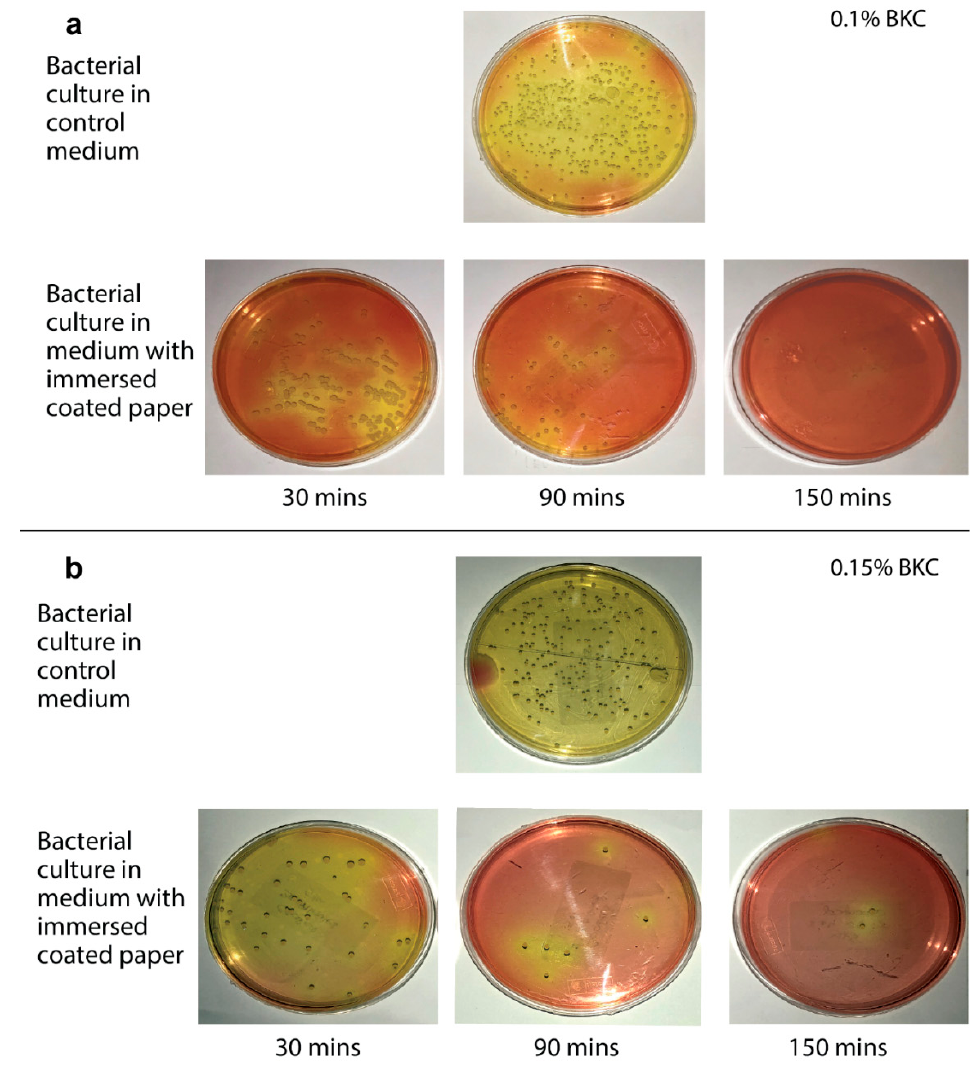
Figure 2. Bacterial cell culture ( S. aureus ) in control experiment and against ( a ) 0.1% BKC and ( b ) 0.15% BKC coated paper at different times of exposure.